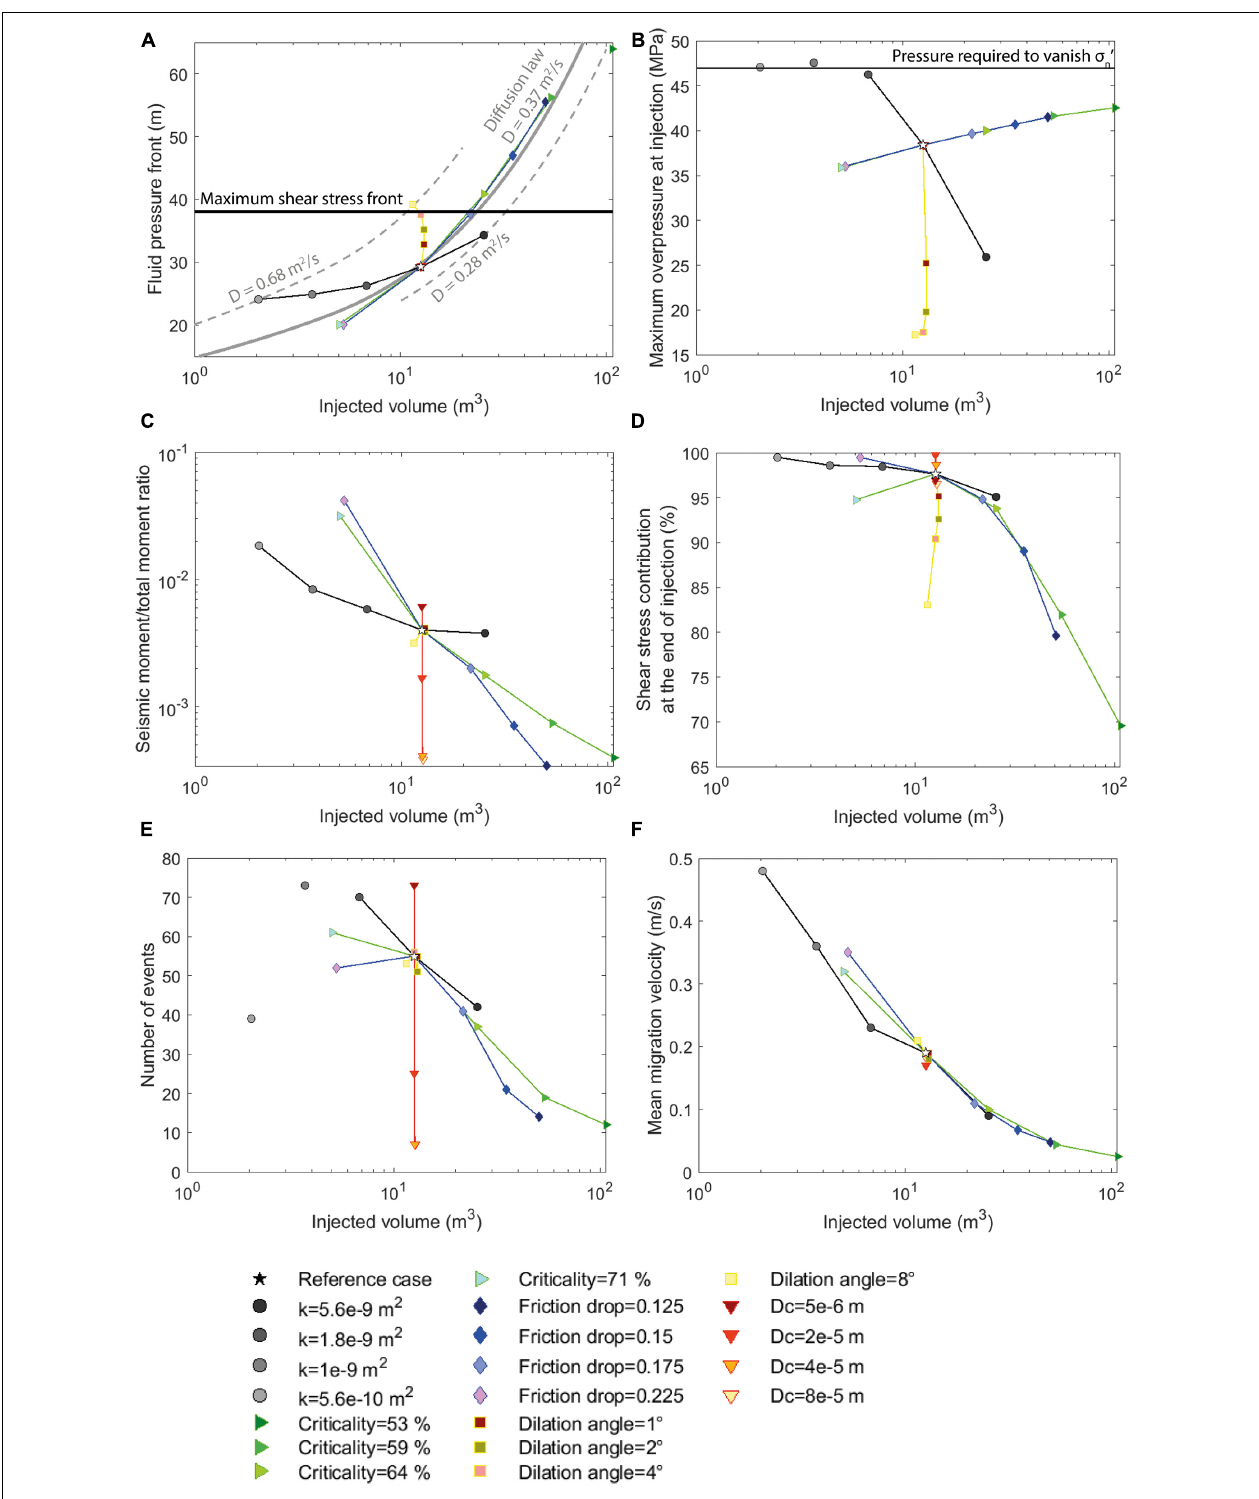
FIGURE 6 | (A) Fluid pressure front, (B) maximum overpressure at injection, (C) seismic-to-total moment ratio, (D) shear stress contribution, (E) number of seismic events, and (F) mean migration velocity as a function of total injected fluid volume for the 21 simulations. Each simulation is defined by a color and a symbol. The reference case is represented by a star. Injection tests with a same varying parameter are linked by a single-colored line. In panel (A) , the black horizontal line shows the position of the maximum shear stress front (fixed for all tests at 38 m from injection point) and the gray curves show theoretical diffusion profiles where D is the hydraulic